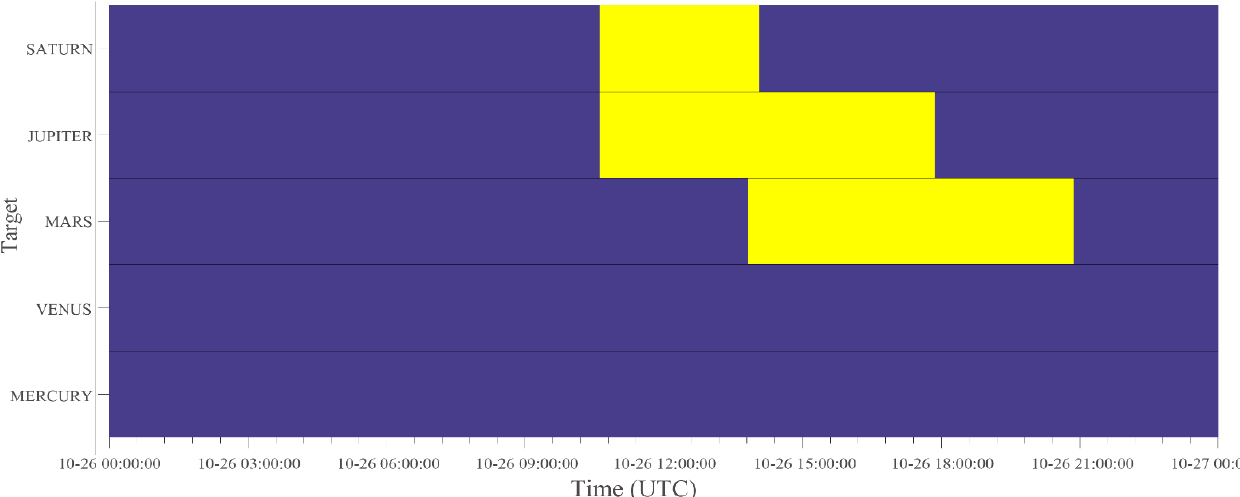
Figure 6. Observation windows on 26 October 2022. Information is shown in the same format as in Figure 4. Table 4. Recommended schedule generated by the AST for VGO on 26 October